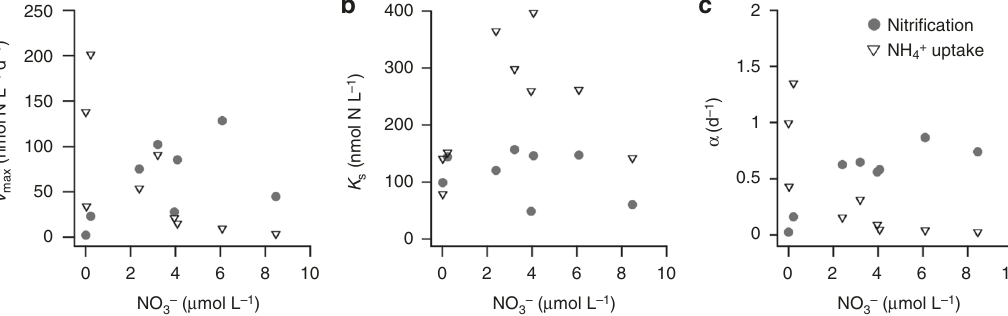
Fig. 3 The kinetic traits of phytoplankton and nitri fi ers under different NO 3 − conditions in the SCS. a The potential maximum reaction rate ( V max ); b the half saturation concentration ( K s ); c the substrate af fi nity ( α ). Solid circles represent kinetic traits of nitri fi cation and open triangles represent NH 4 +